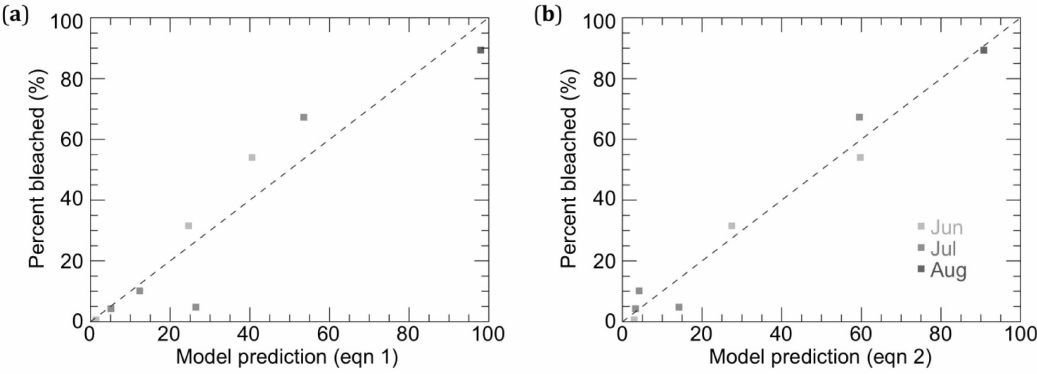
Figure 7. Modeled predictions of percent bleaching, as functions of thermal stress accumulation (DHW) and generic richness. Models based on ( a ) the product of DHW and generic richness (Equation (1)); and ( b ) the product of exponential factors of DHW and generic richness (Equation (2)). Symbol color indicates the month of observation. The line of unity is also shown